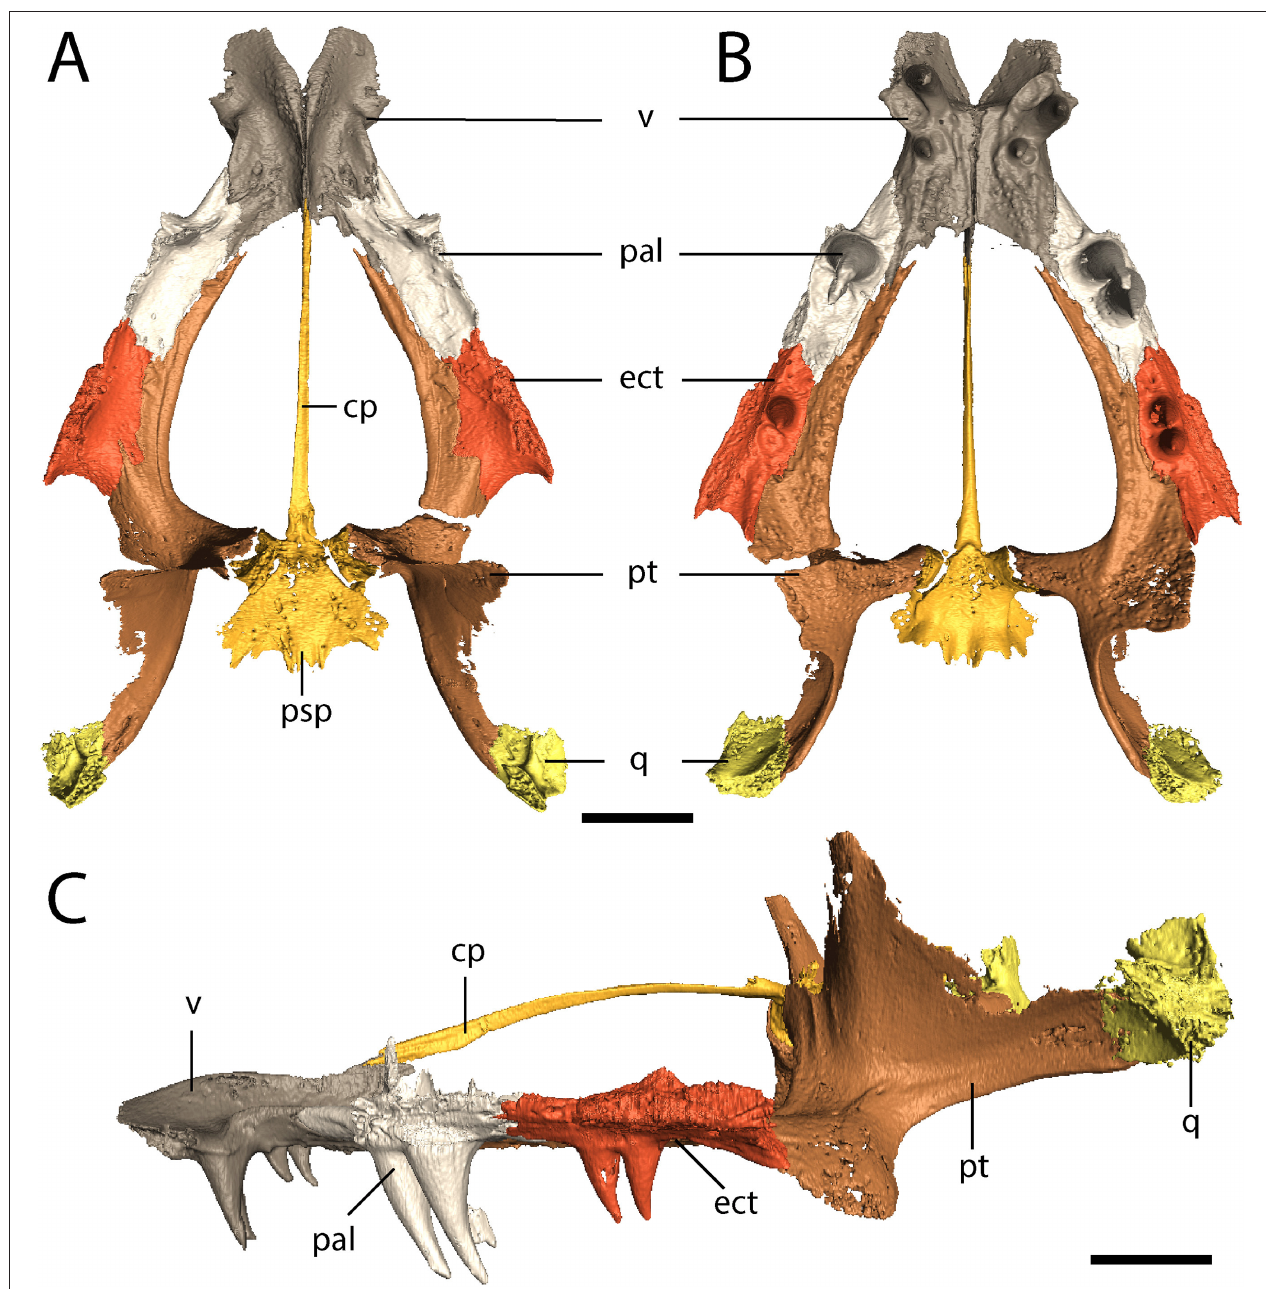
FIGURE 7 | OMNH 79318, cf. Acheloma , isolated renderings of the palate. (A) dorsal profile; (B) ventral profile; (C) left lateral profile. Scale bar equal to